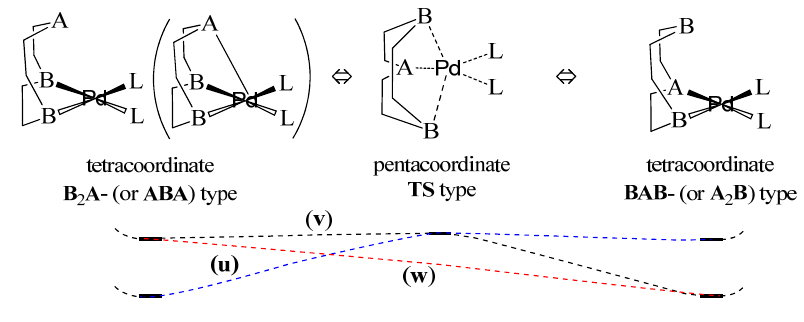
Figure 6. The variation of the structural configuration from endo -Pd([9]ane B A ) L {or 2 2 } complex to endo -Pd([9]ane BAB ) L {or endo -Pd([9]ane A B ) L } endo -Pd([9]ane ABA ) L 2 2 2 2 complex, including the relative energy level ( A :P, S; B :N). ( u ) is a reaction path from the pentacoordinate endo -[Pd([9]ane B A )( L -donor) ] 2+ complex with an axial (soft A --Pd) quasi- 2 2 bond to endo -[Pd([9]ane BAB )( L -donor) ] 2+ . ( v ) is a reaction path from the tetracoordinate 2 endo -Pd([9]ane B A )( L -acceptor) complex with a trans L -acceptor to endo -Pd([9]ane BAB ) 2 2 ( L -acceptor) . ( w ) is a reaction path from the endo- Pd([9]ane PNP )( L -donor) complex to 2 2 endo- Pd([9]ane P N )( L -donor) without the transition energy 2 2